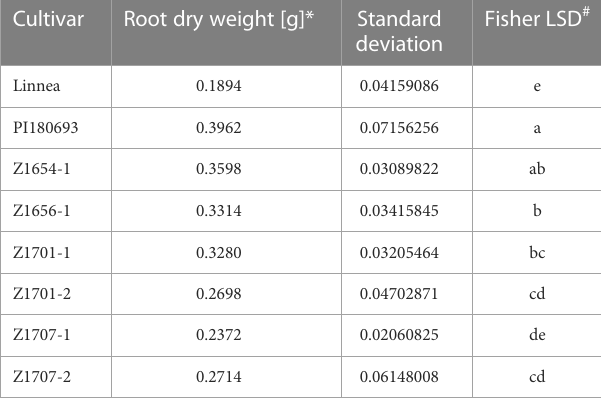
TABLE 3 Root dry weight of uninfected pea cultivars in growth chamber